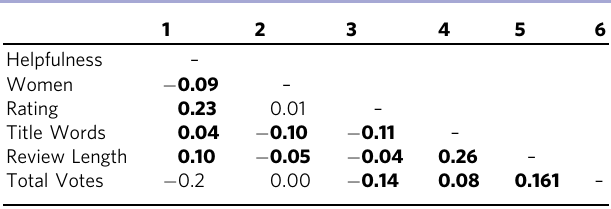
Table 6 Pearson correlations of amazon data full